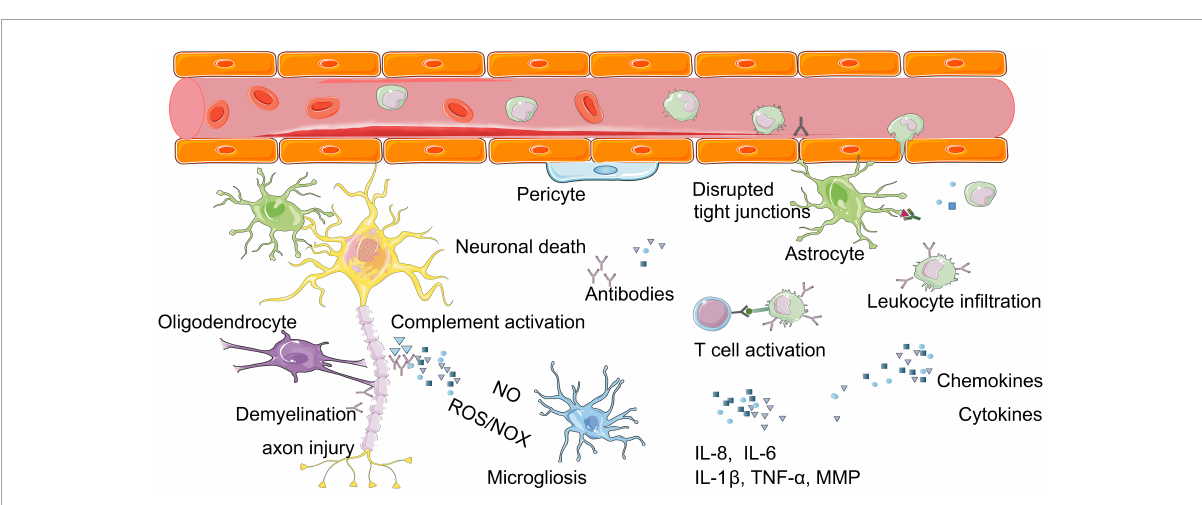
FIGURE2 Molecular mechanisms of neuroinflammation after burn injury. Burn injury can cause a series of inflammatory reactions in brain, for example, the release of inflammatory mediators (chemokines, cytokines), the imbalance of immune system (T cell activation, complement activation). These above can lead to changes such as neuronal cell death, demyelination, axon injury, glial cell activation. ROS, reactive oxygen species; NOX, nitric oxide; IL-8, interleukin-8; IL-6, interleukin-6; IL-1 β , interleukin-1 beta; MMPs, matrix